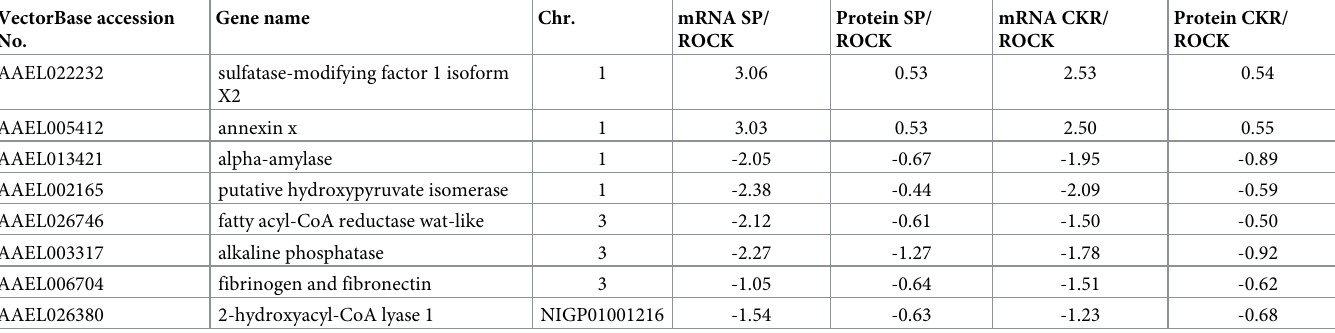
Values indicate the log 2 (FC) of the up-or down-regulated non-CYP genes. The expression of CYPs is presented in Table